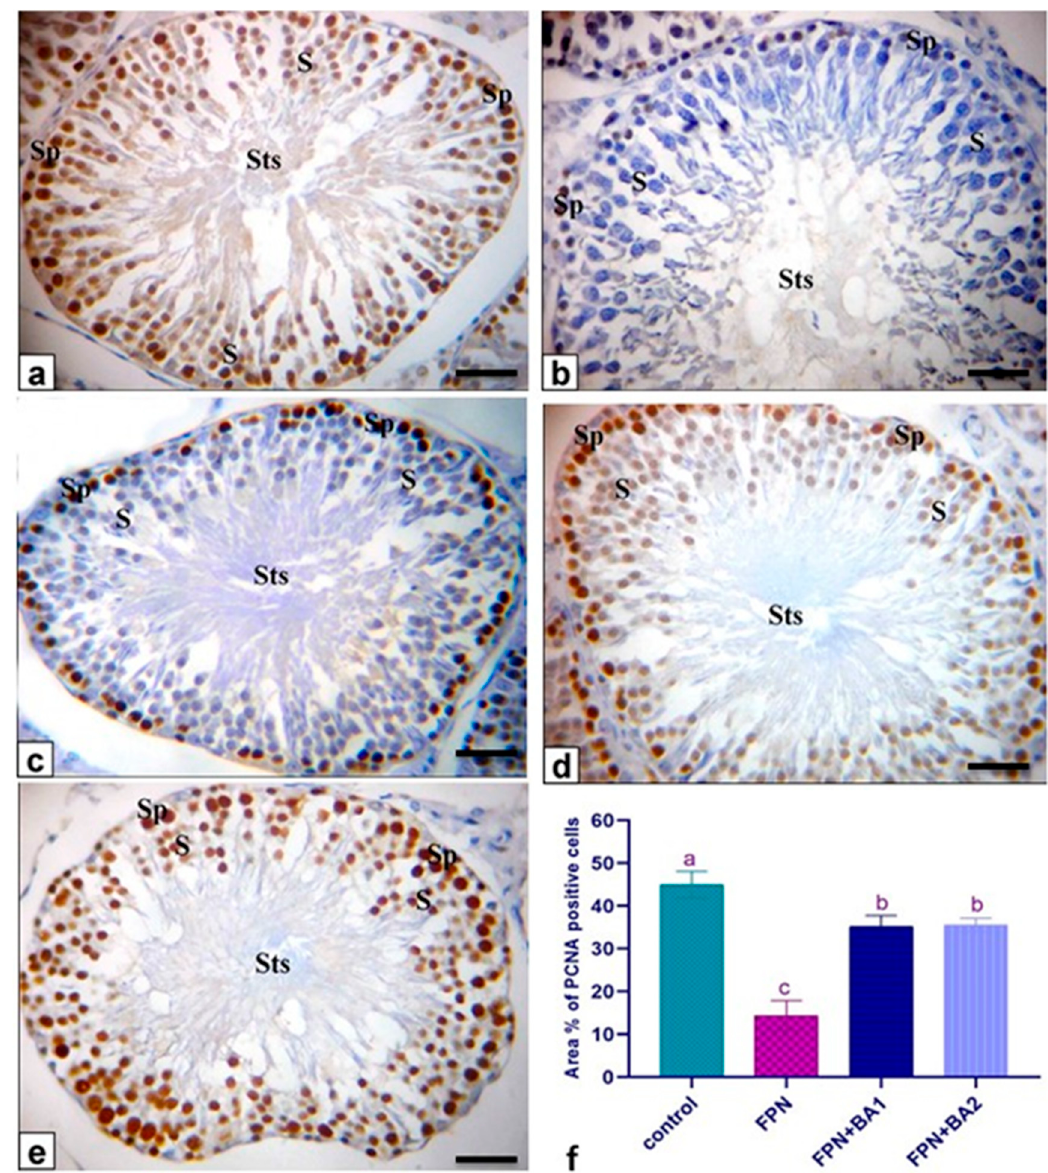
Figure 7. Photomicrograph of rat seminiferous tubules (Sts) showing positive brown proliferating cell nuclear antigen (PCNA) immunostaining. Bar = 50 µm. ( a ) Control rat showing positive brown PCNA immunoreactions in the nuclei of spermatogonia (Sp) and spermatocytes (S). ( b , c ) FPN-treated rats showing that most of the seminiferous tubules have negative immunostained in the nuclei of spermatogonia and spermatocytes. In contrast, other seminiferous tubules have few PCNA immunoreactions in the nuclei of the spermatogenic cells and negative spermatocytes. ( d ) FPN + BA 1 rats were showing positive brown PCNA immunoreactions in the nuclei of spermatogonia and spermatocytes ( b ) FPN + BA 2 rats showing positive brown PCNA immunoreactions in the nuclei of spermatogonia and spermatocytes. ( f ) Area percentage of PCNA positive brown-stained cells. All the values were expressed as mean ± SEM. Different small letters indicate significant at p < 0.0001. ( a – c ) Mean values with different letters within columns are significantly different at p ≤ 0.05 (ANOVA) with Duncan’s multiple range test.